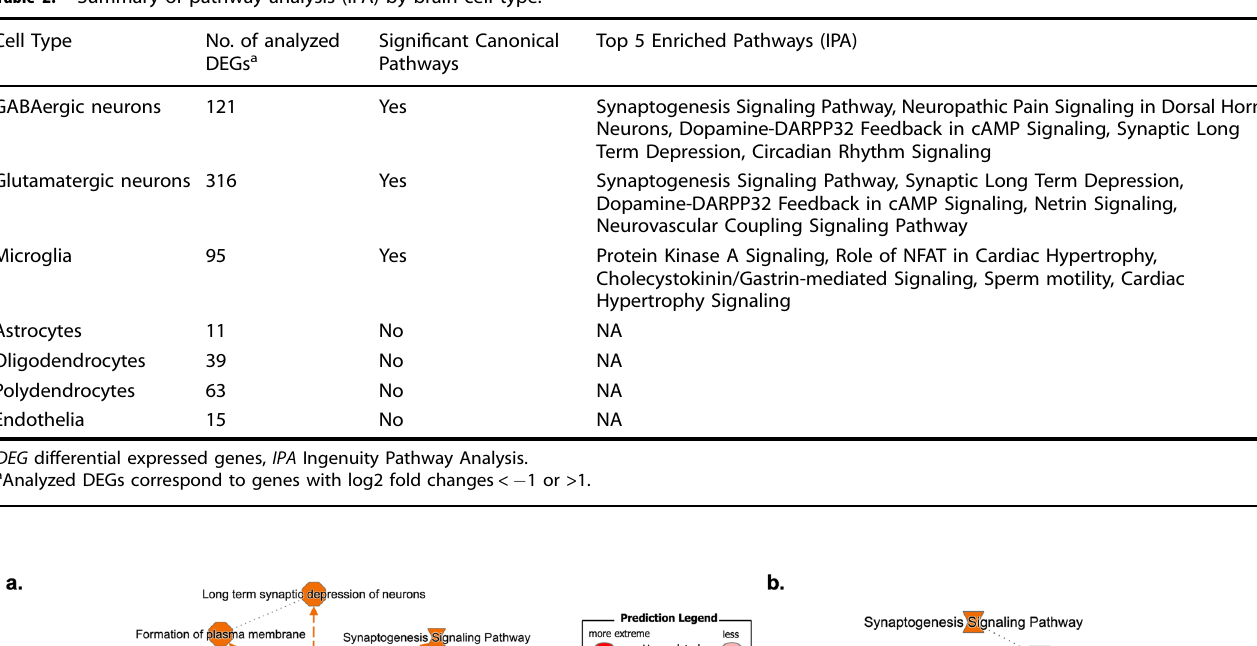
Table 2. Summary of pathway analysis (IPA) by brain cell type.